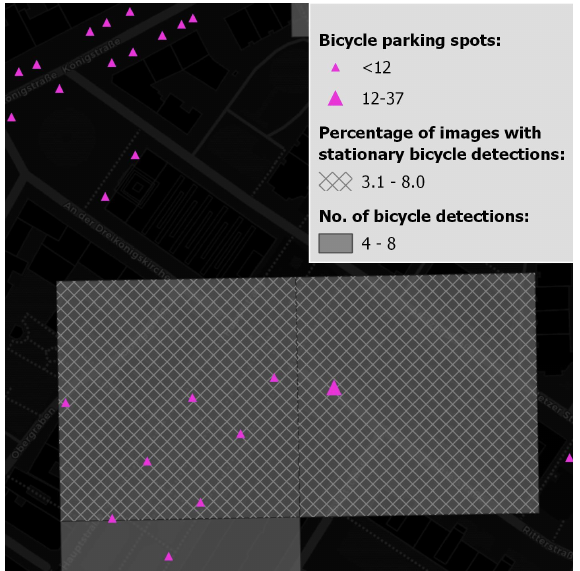
Figure 14. Example of a visually identified 100 × 100 m grid cell (left) that contains significantly more than enough bicycle parking capacity that it appears to be in demand. There are seven parking areas of capacity up to 12 bicycles, while there are only 4 to 8 bicycles detected inside the cell ( N PB